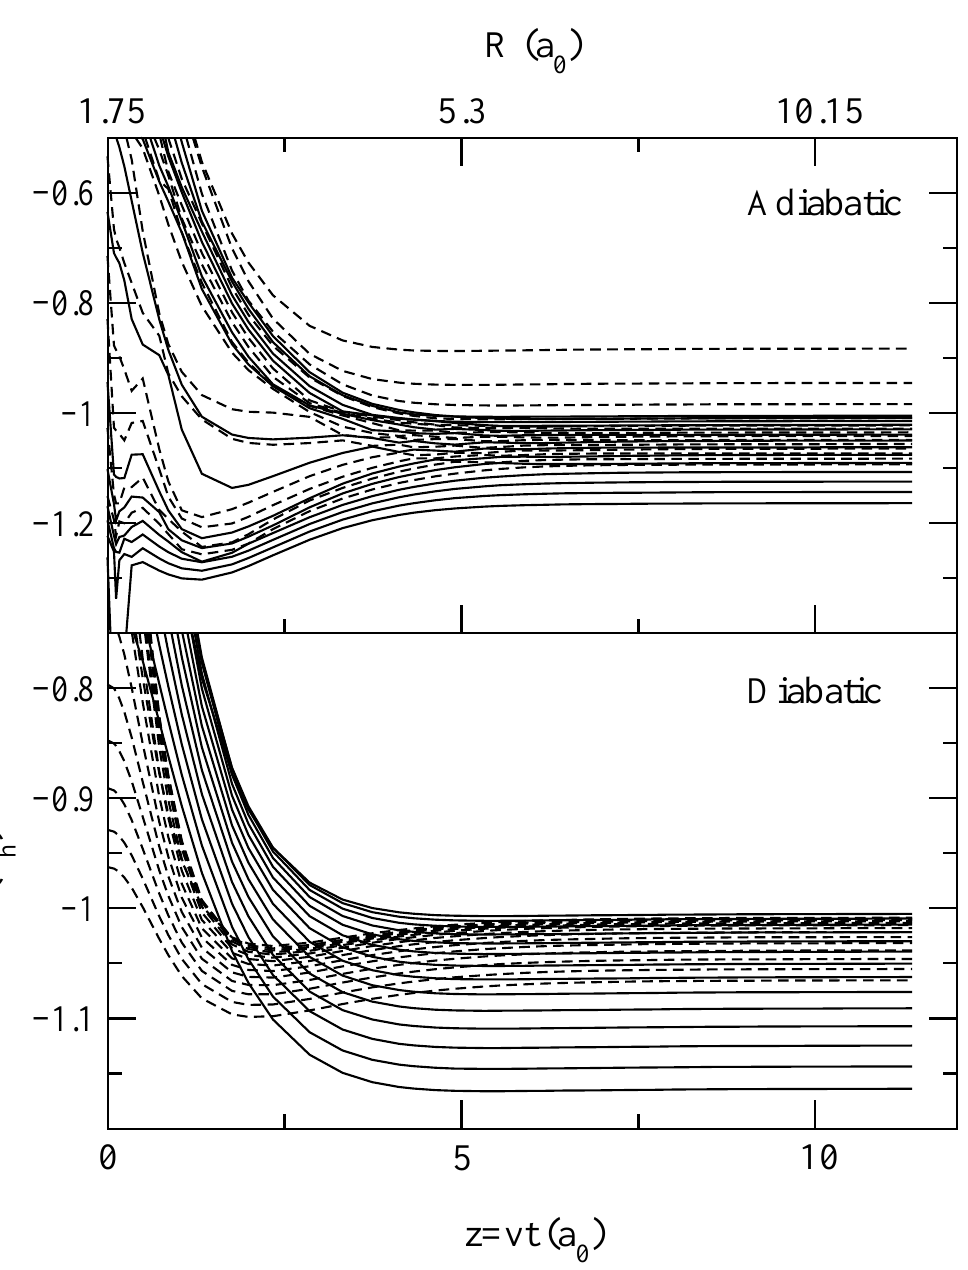
Figure 8: Same as fig. 7, but for trajectory